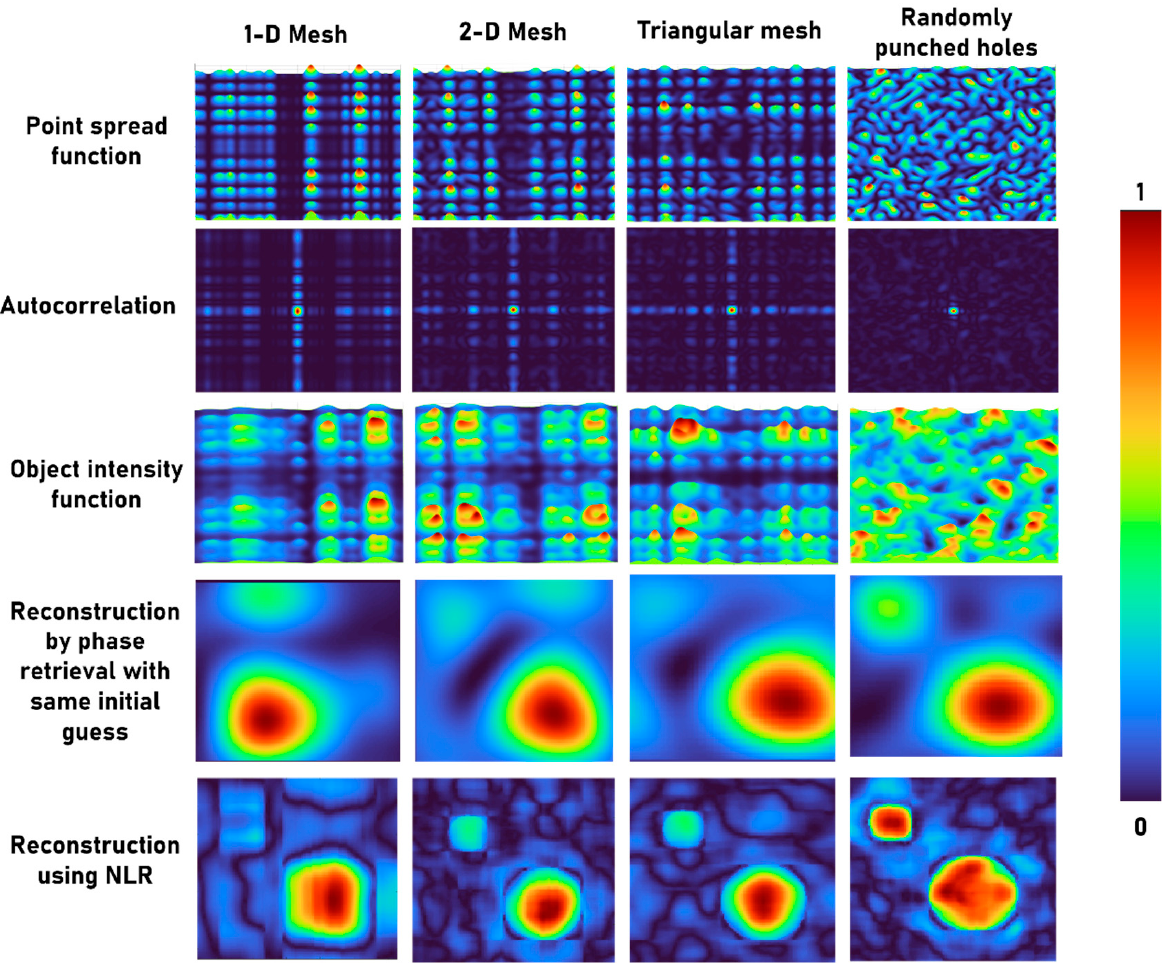
Figure 4. Simulated PSF, autocorrelation of PSF, object intensity function, reconstruction using phase retrieval and NLR Figure 1. D mesh, 2-D mesh, triangular mesh and randomly arranged holes in a metal plate. All the images are normalized to a range of values between 0 and 1.